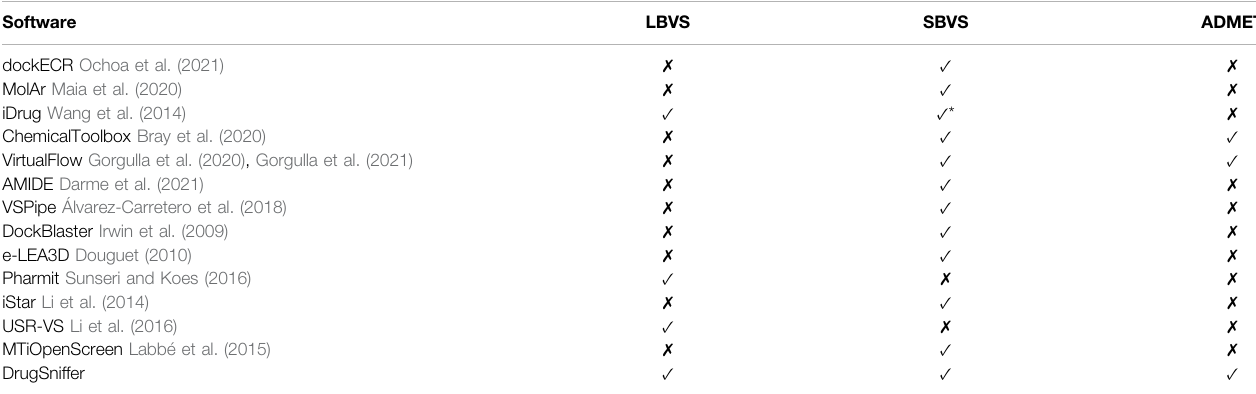
TABLE 1 | Several open access software tools for virtual screening. In a number of the tools, such as dockECR and VirtualFlow, multiple docking programs are used to predict scores between a single target or multiple targets (merging and shrinking approach) and a library of compounds. The AMIDE software carries out large-scale chemical ligand docking over a large dataset of proteins with the aim of identifying potential side effects of new drugs. iDrug, Pharmit (for structure-based pharmacophore modeling), iStar, e-LEA3D, USR-VS (3D shape-based similarity), MTiOpenScreen and ChemicalToolbox are web-based platforms for computer-aided drug design. ChemicalToolbox allows for integration with other tools and work fl ows (molecular dynamics) that are part of the Galaxy software framework (https://galaxyproject.org/). e-LEA3Dusesa denovo drugdesignstrategyinwhichfragmentsorcombinationoffragmentsthat fi taQSARmodelorthebindingsiteofaprotein areidenti fi ed.*iDrug uses a pocket structure to de fi ne the pharmacophore descriptors needed for LBVS. However, they do not explicitly calculate the interaction between a ligand and the pocket, such as docking. In our opinion, they are marginally